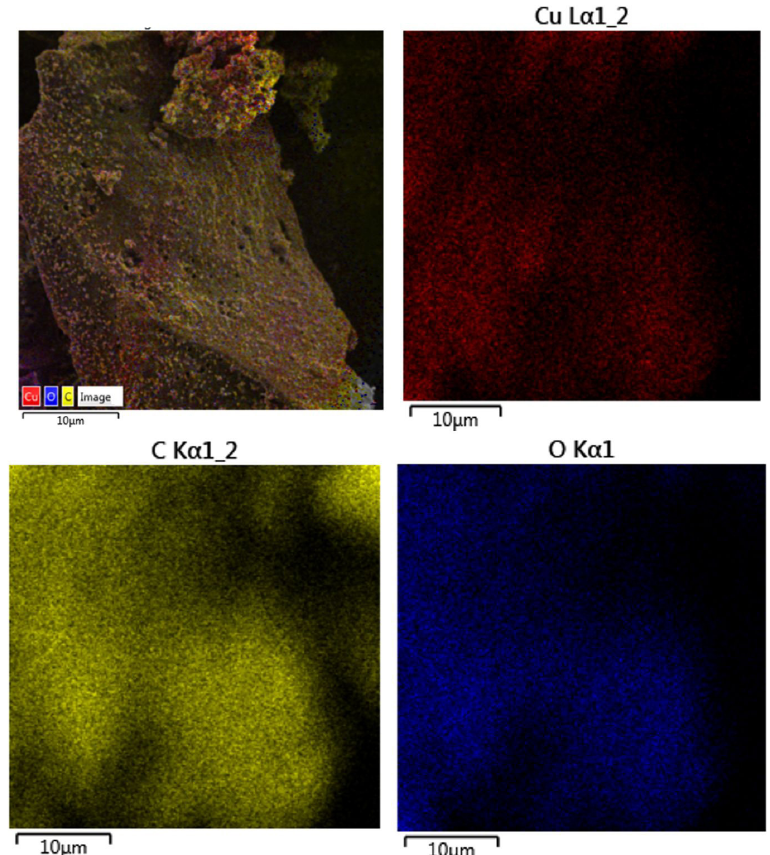
Figure 5. EDS analysis of the C–Cu composite.